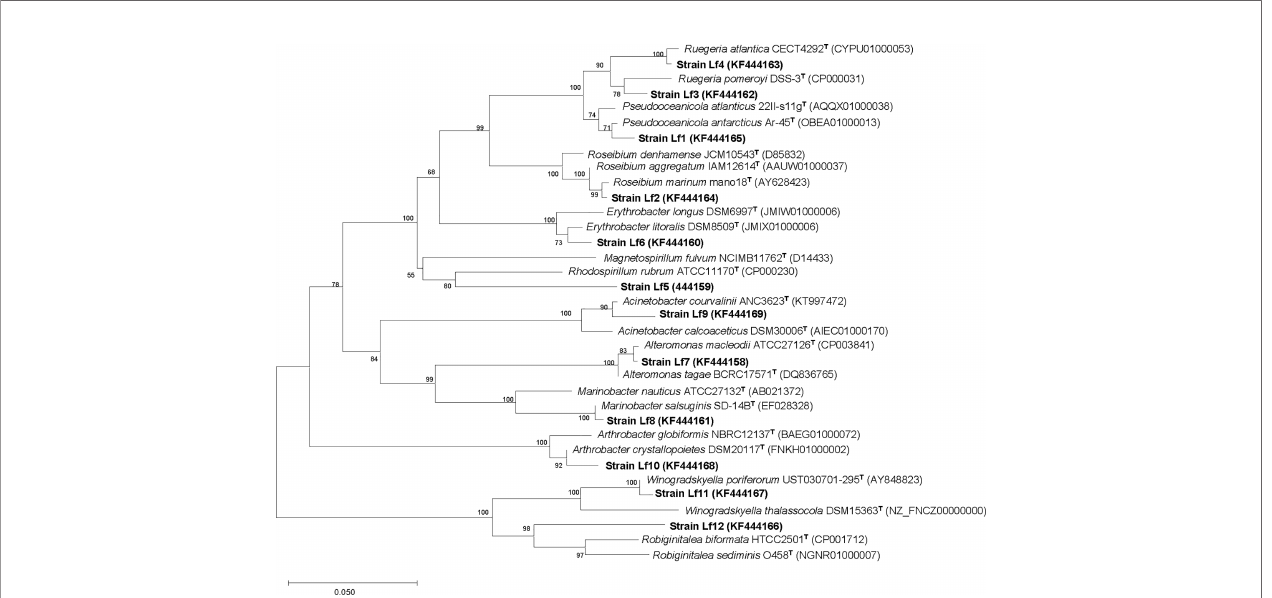
FIGURE 1 | Neighbor-joining tree, showing the phylogenetic position of bacterial strains isolated from phycosphere of Levanderina fi ssa and type strains of most phylogenetically related taxa (type species included) based on partial 16S rRNA gene sequences. GenBank accession numbers are given. Bootstrap analysis was made with 1000 resamplings; percentages of support are shown at nodes, Bar, 5% sequence